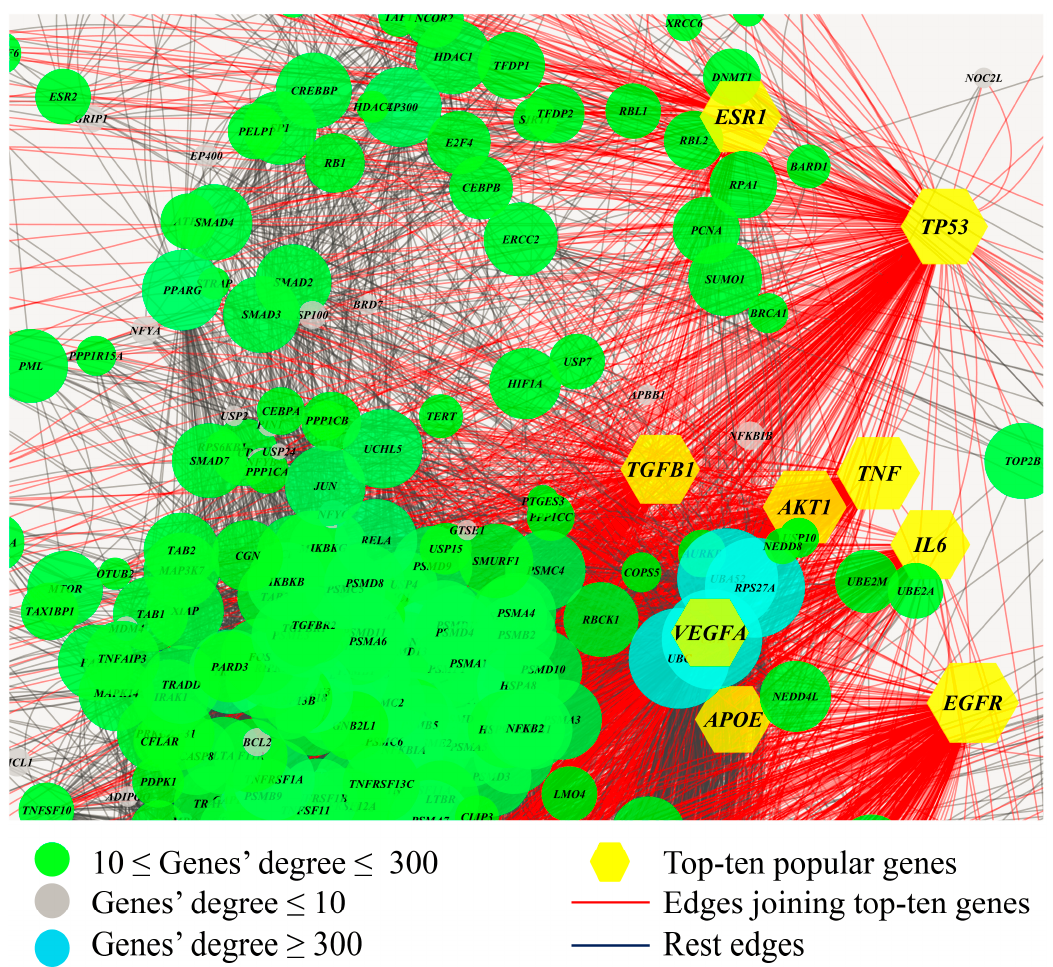
Figure 1. A partial view of the integrated biomolecular network. The meanings of the colors of the nodes and edges are shown in the legend. The nodes size is in proportion to the number of its neighbors.